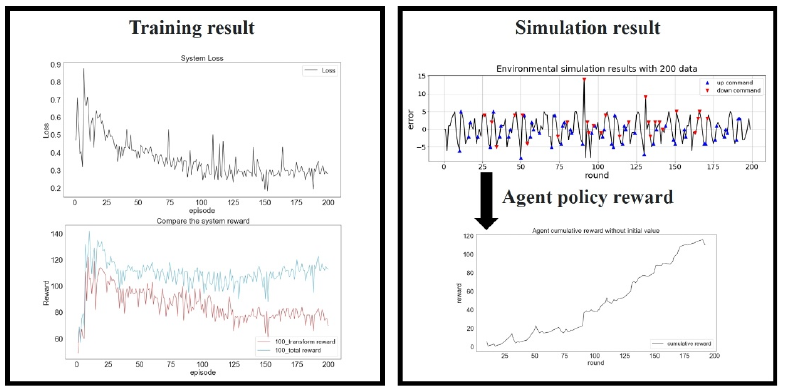
Figure 14. Training results for 200 data. Loss function ( top left ), reward ( bottom left ), simulated platform positioning ( top right ), and the agent policy reward ( bottom right ).